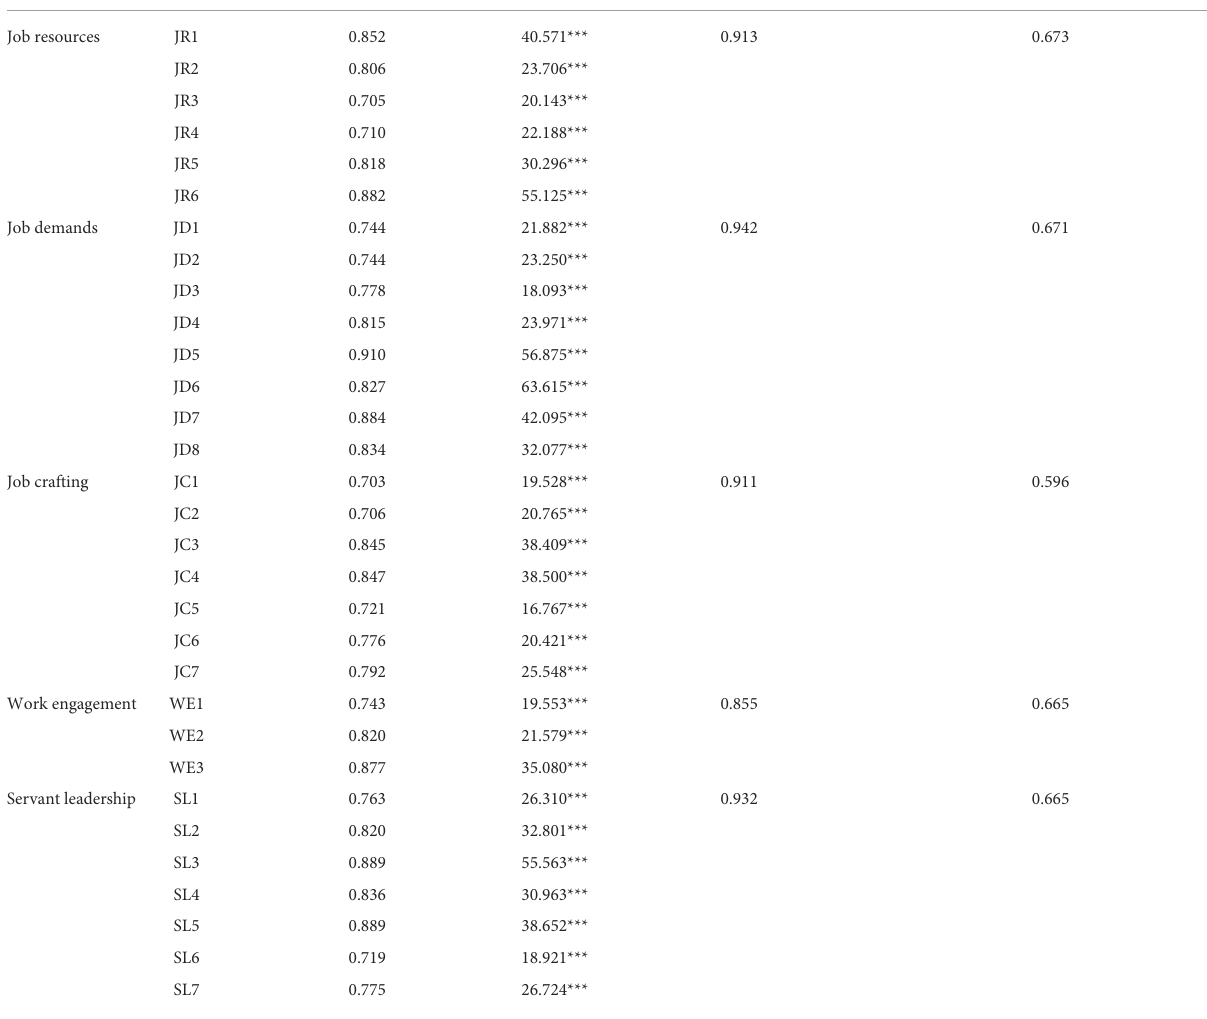
TABLE 1 Standardized factor loading, construct reliability and convergent validity.